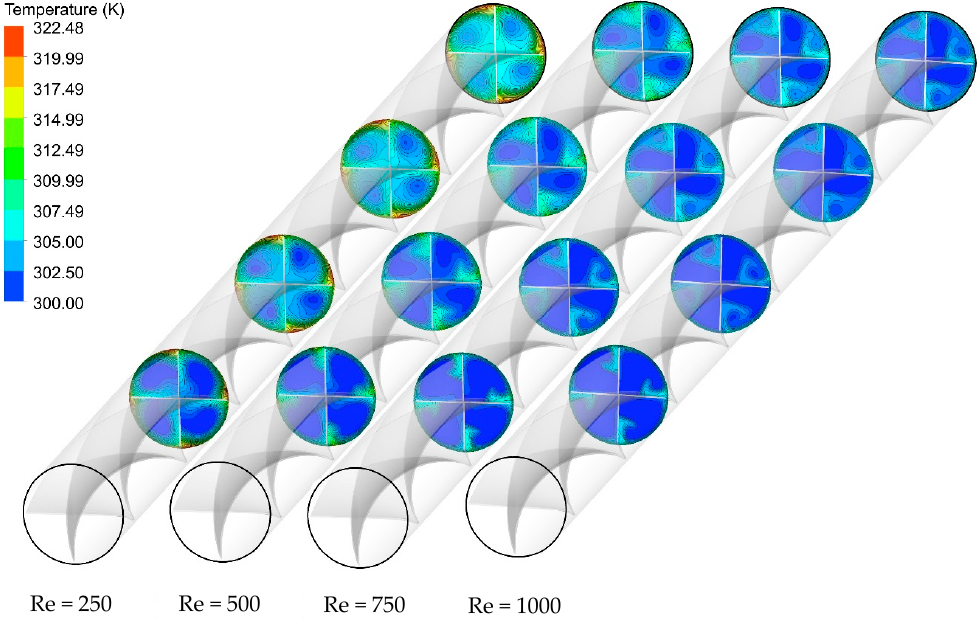
Figure 14. Cross-sectional temperature contours for Case 5 at different Re numbers and ϕ = 0%.